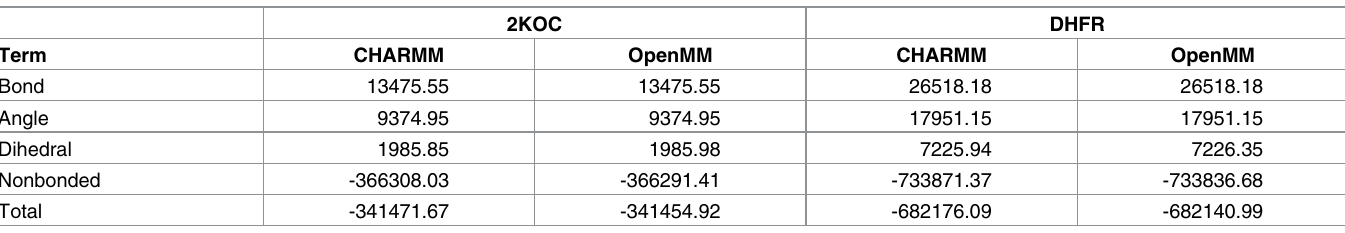
These tests use the CHARMM36 force